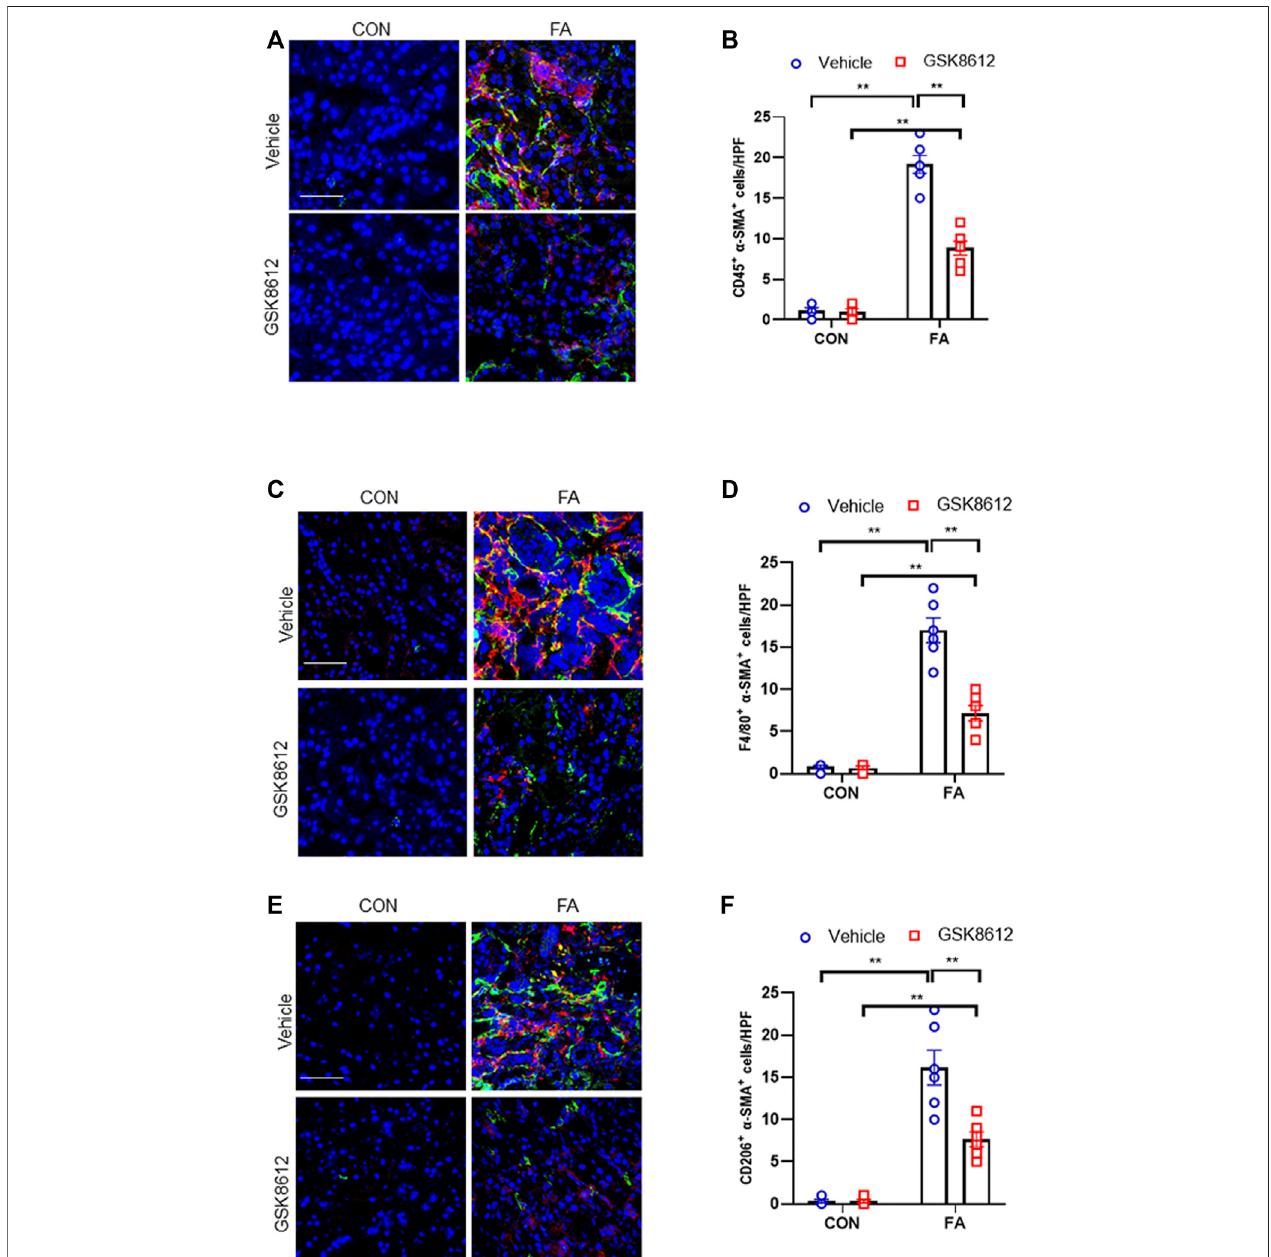
FIGURE 6 | Pharmacological inhibition of TBK1 impedes myeloid fi broblast activation and MMT in FA nephropathy. (A) Representative immuno fl uorescence photomicrographs of kidney sections in each group stained for CD45 (red), α -SMA (green), and DAPI (blue). (B) Quantitative analysis of CD45 and α -SMA dual positive cellsinthekidneys. (C) Representativeimmuno fl uorescencephotomicrographsofkidneysectionsineachgroupstainedforF4/80(red), α -SMA(green),andDAPI(blue). (D) Quantitative analysis of F4/80 and α -SMA dual positive cells in the kidneys. (E) Representative immuno fl uorescence photomicrographs of kidney sections in each group stained for CD206 (red), α -SMA (green), and DAPI (blue). (F) Quantitative analysis of CD206 and α -SMA dual positive cells in the kidneys. ** p < 0.01; n = 6 in each group; Scale bar: 50 μ m.